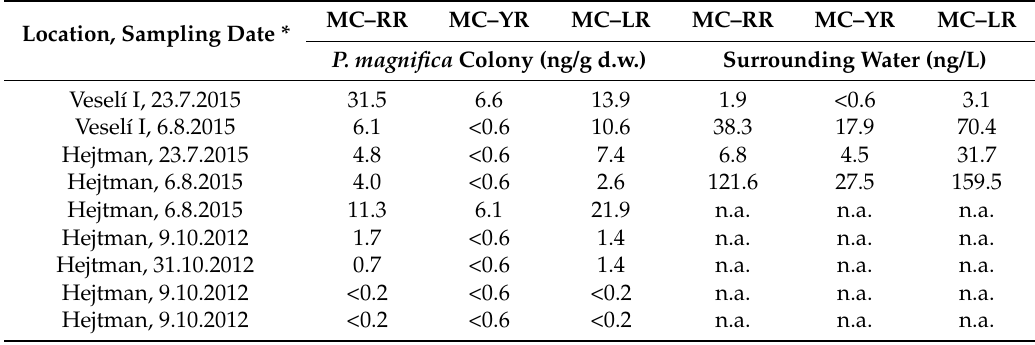
Table 3. Microcystin (MC) determination, the values are concentrations determined in ng/g d.w. for biomass and ng/L for surrounding